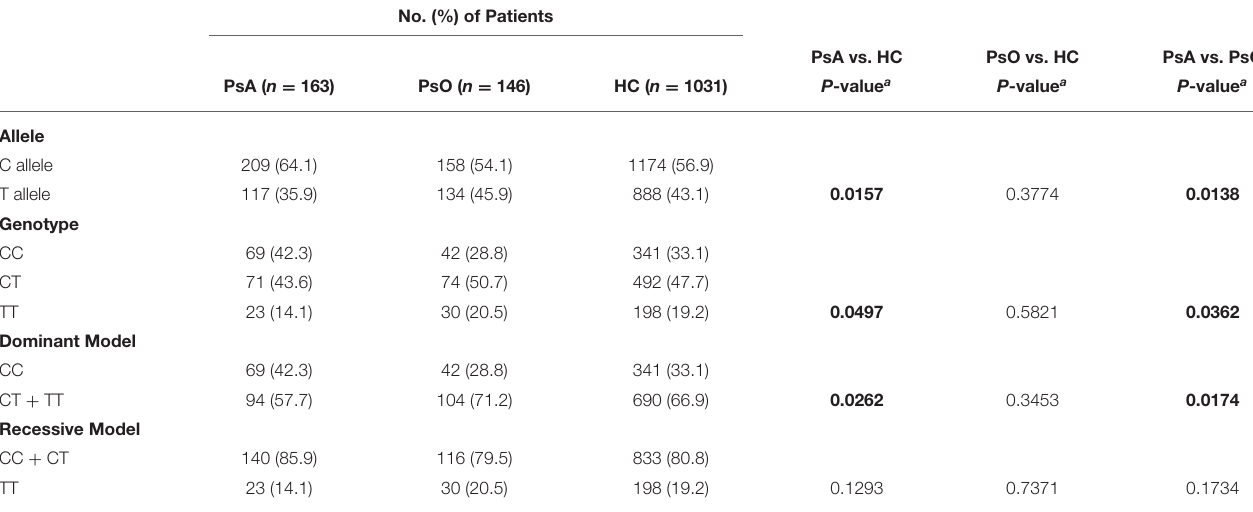
TABLE 2 | The distribution of MTHFR SNP rs1801133 in patients with PsO and patients with PsA and the healthy controls. No. (%) of Patients PsA vs. HC PsO vs.